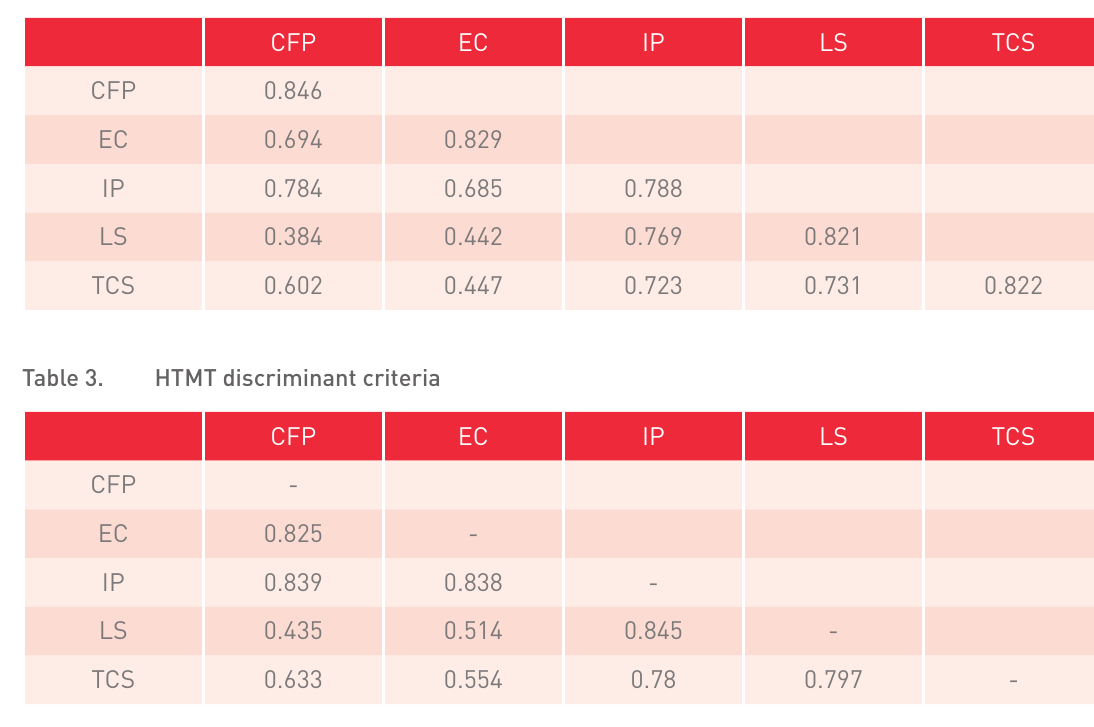
Latent Variable Correlations-Square Root of